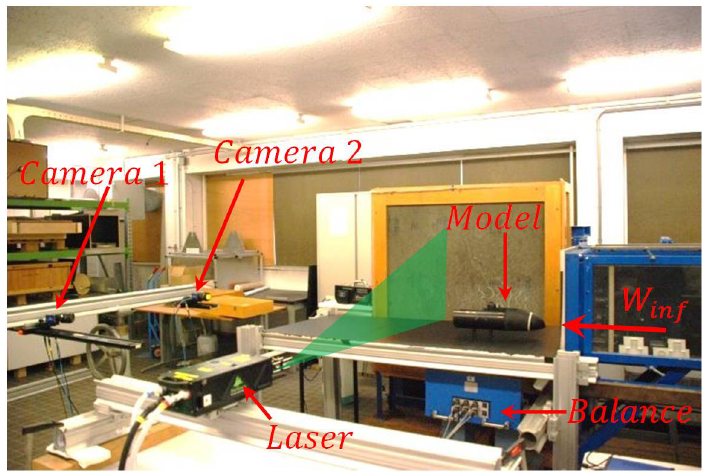
Figure 1. Setup of the stereoscopic PIV and balance